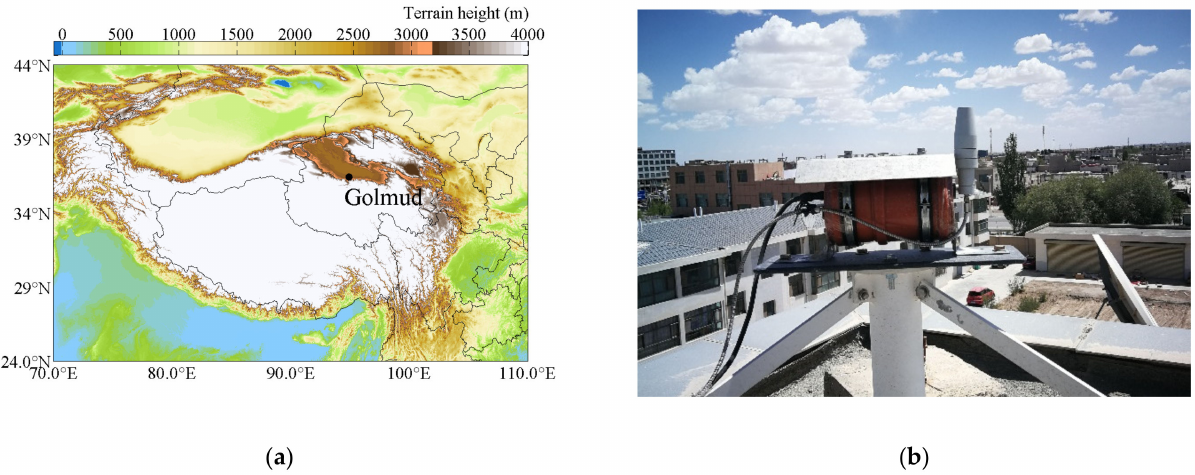
Figure 1. ( a ) Geographical location of the Golmud meteorological station in the northern Tibetan Plateau. The observatory is marked by a black dot; ( b ) image of the Tube MAX-DOAS